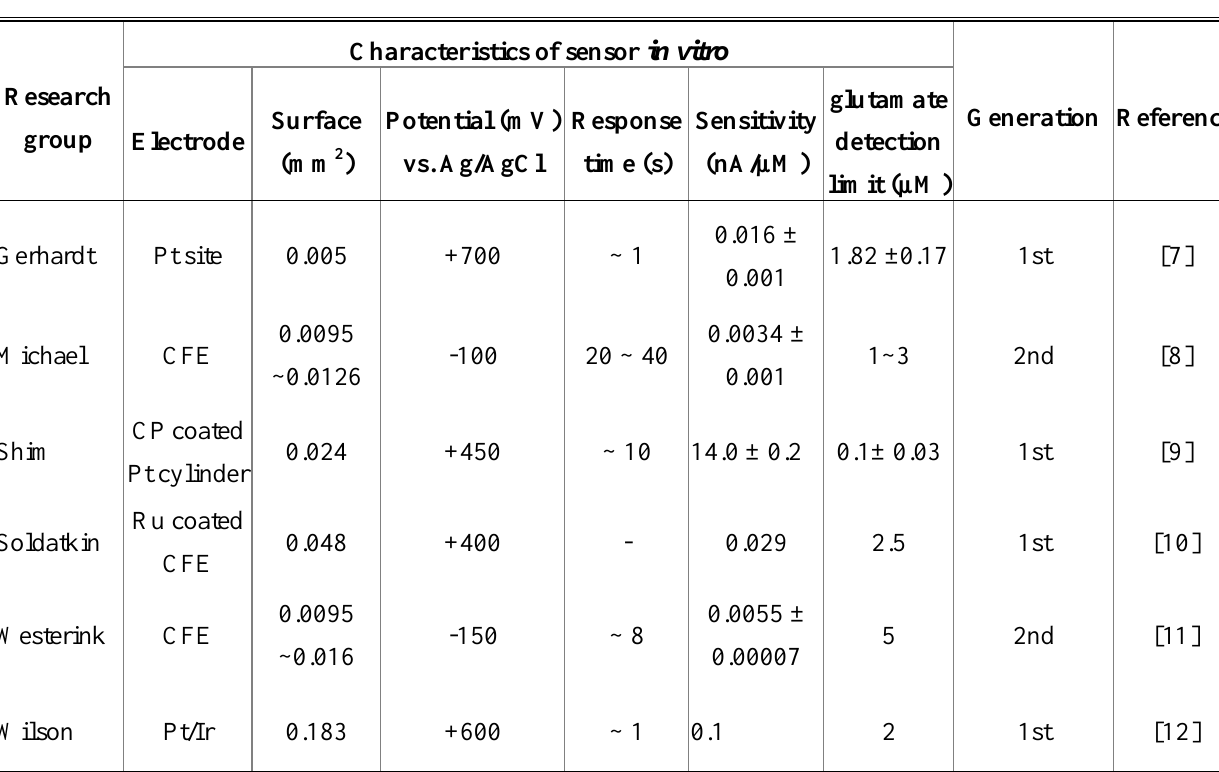
Table 1. Different types of enzyme-based amperometric glutamate microbiosensor. CFE, carbon fiber electrode; CP, contact polymer; Ru, ruthenium; SCE, Saturated calomel electrode; Ir, iridium.